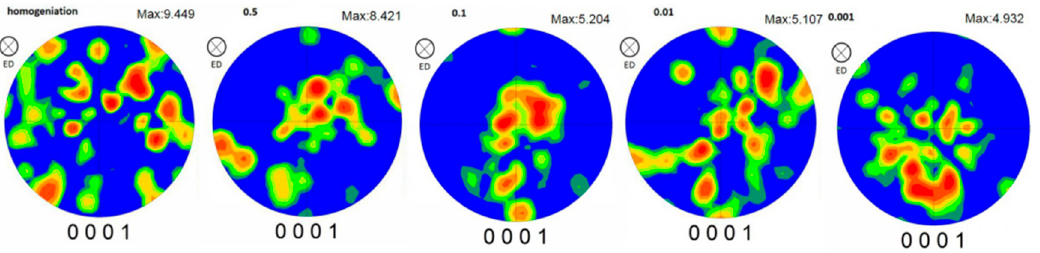
Figure 7. The (0001) pole figure at each strain rate.